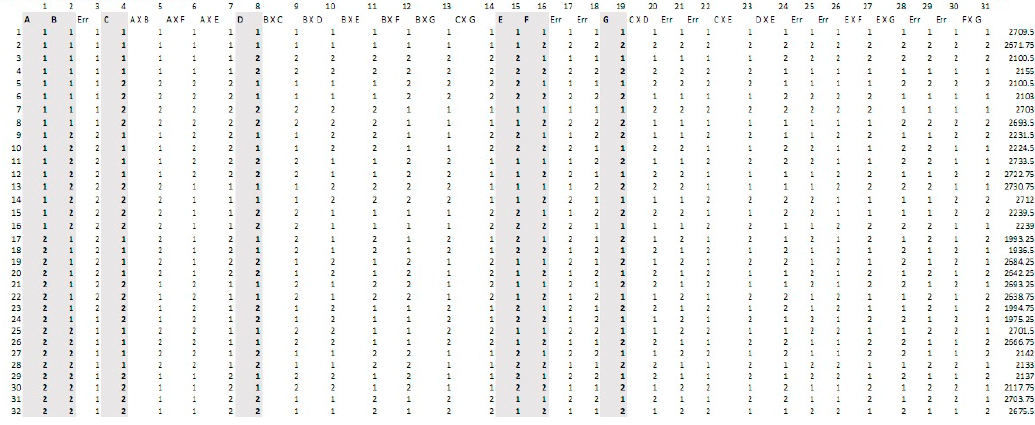
Figure A1. The completed L32 orthogonal array.